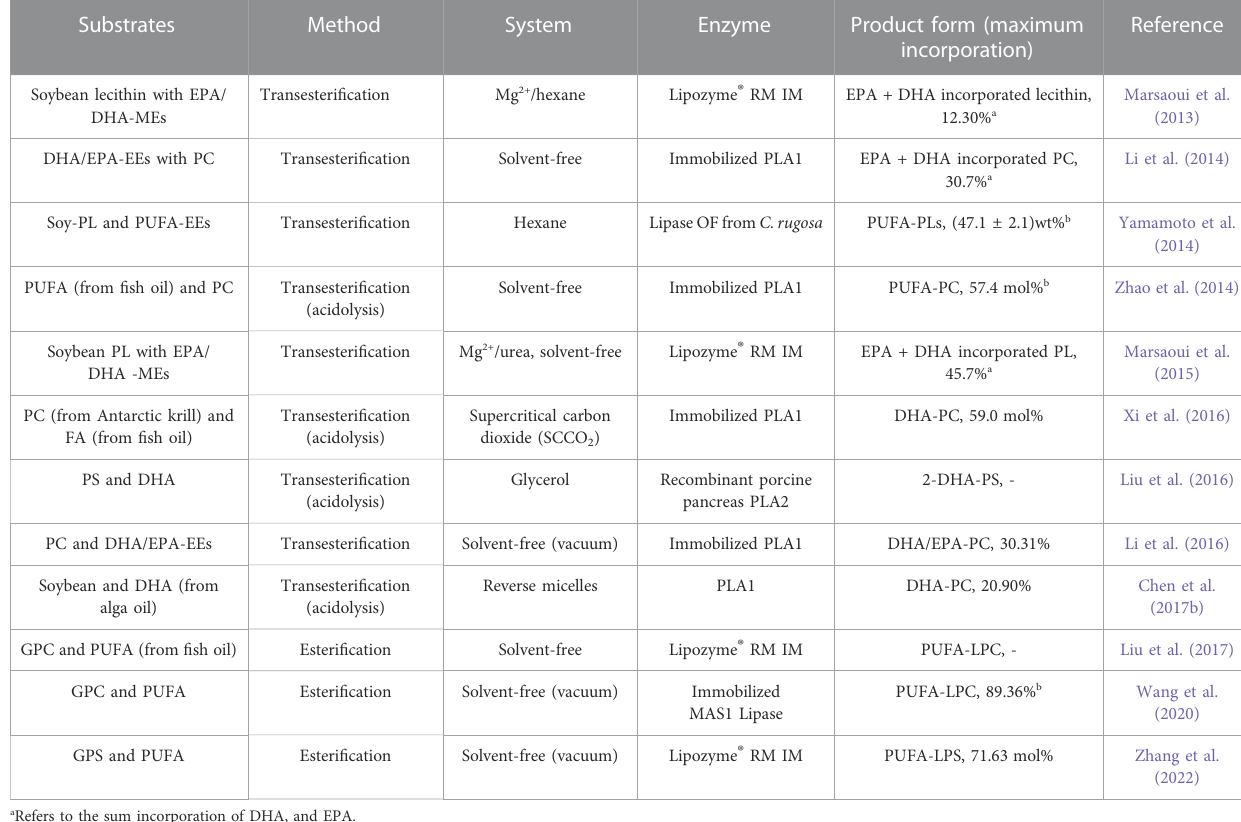
TABLE 1 Studies on the lipase-catalyzed synthesis of DHA-PLs in the past decade.